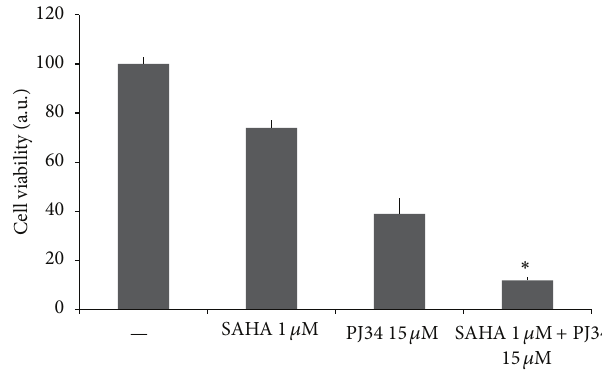
Figure 2: Effect of HDAC and PARP inhibitors combination on SW1736 cell viability. Cells were treated for 72 h with SAHA 1 𝜇 M and PJ34 15 𝜇 M, alone or in combination. CellTiter-Blue Cell Viability assay was performed as described in Section 2. Bars indicate the percentage of viable cells versus controls (untreated cells) and represent means ± SD of four experiments. ∗ indicates values significantly different compared to all other